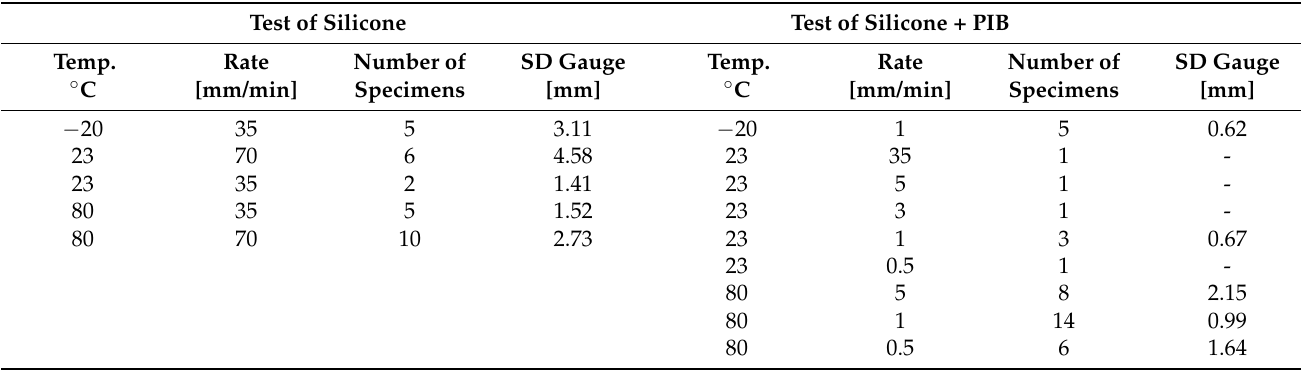
Table 1. Silicone specimens subjected to the tensile test (left) and to tear test (right). Test of Silicone Test of Silicone + PIB Temp. ◦